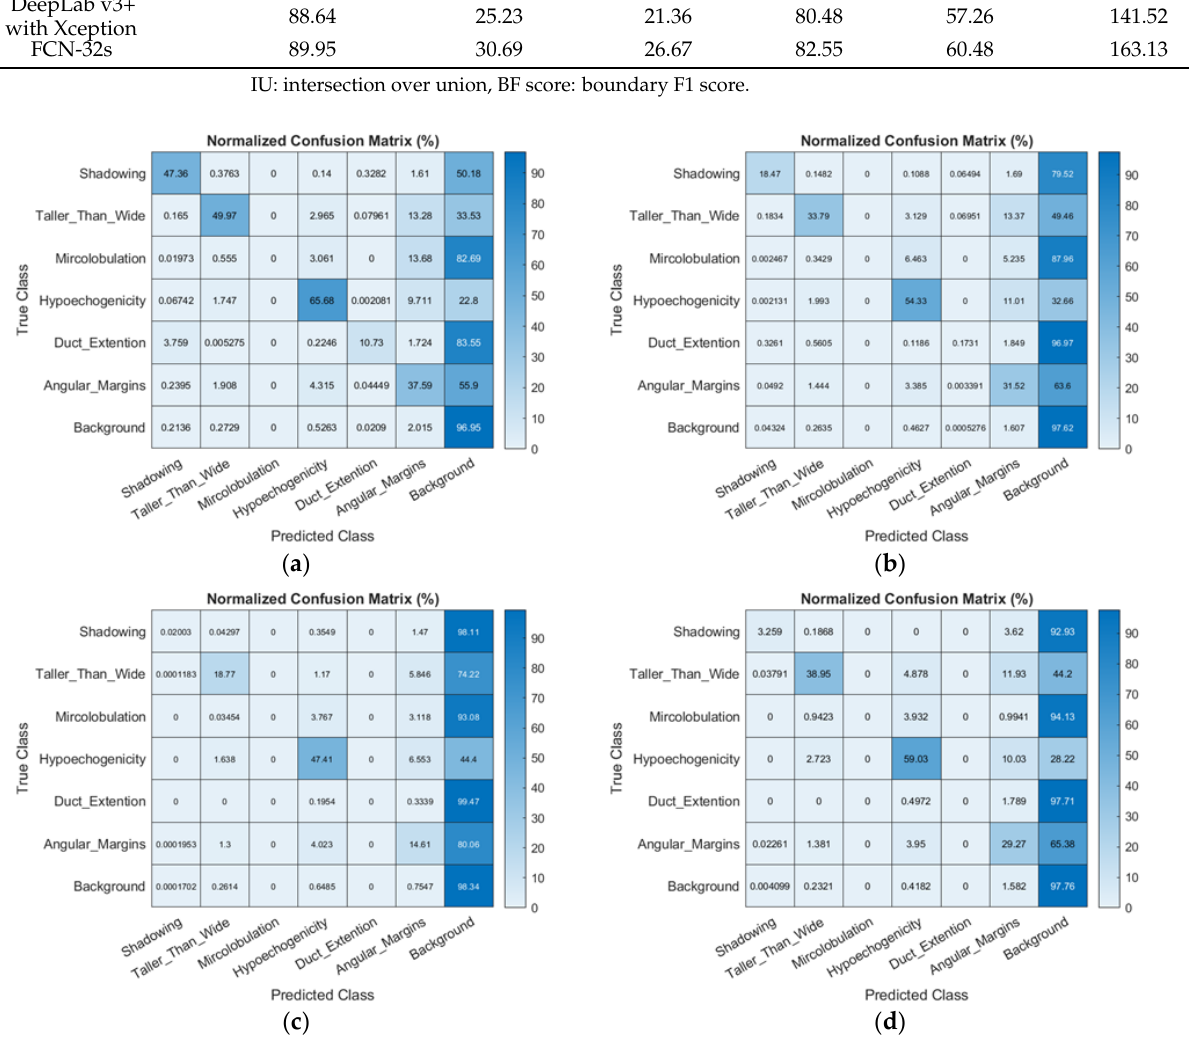
Table 3. Semantic segmentation performance and average run time results for DeepLab v3+ with